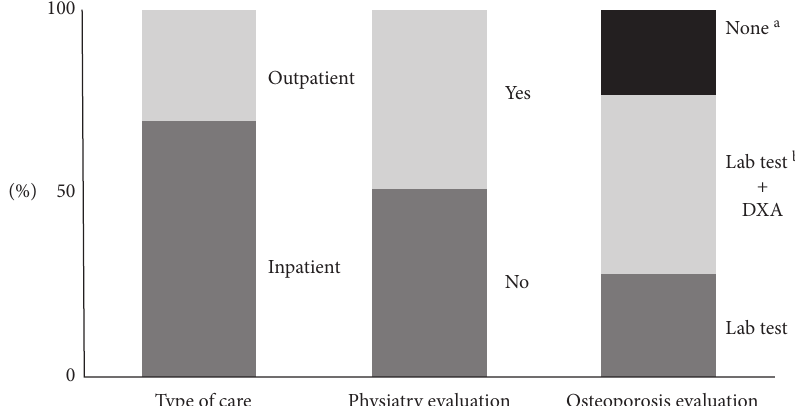
Figure 3: Assessment and care of fragility fracture patients during the study period. a Twenty-three percent of patients ( n � 44) were not evaluated since they already had a diagnosis of osteoporosis. b Laboratory testing included serum albumin, complete blood count, serum creatinine, vitamin D levels, total calcium, alkaline phosphatase, and parathormone and DXA dual-energy X-ray absorptiometry.